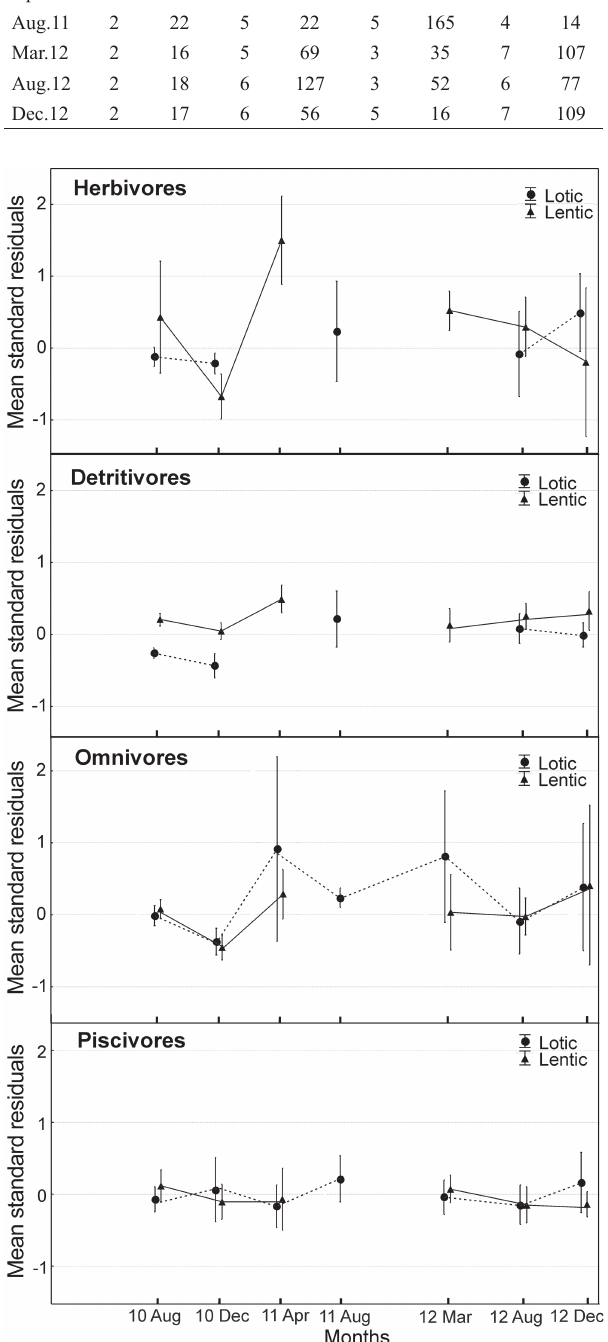
Fig. 4. Mean and standard error of standardized residuals for fish trophic groups by environments during the study